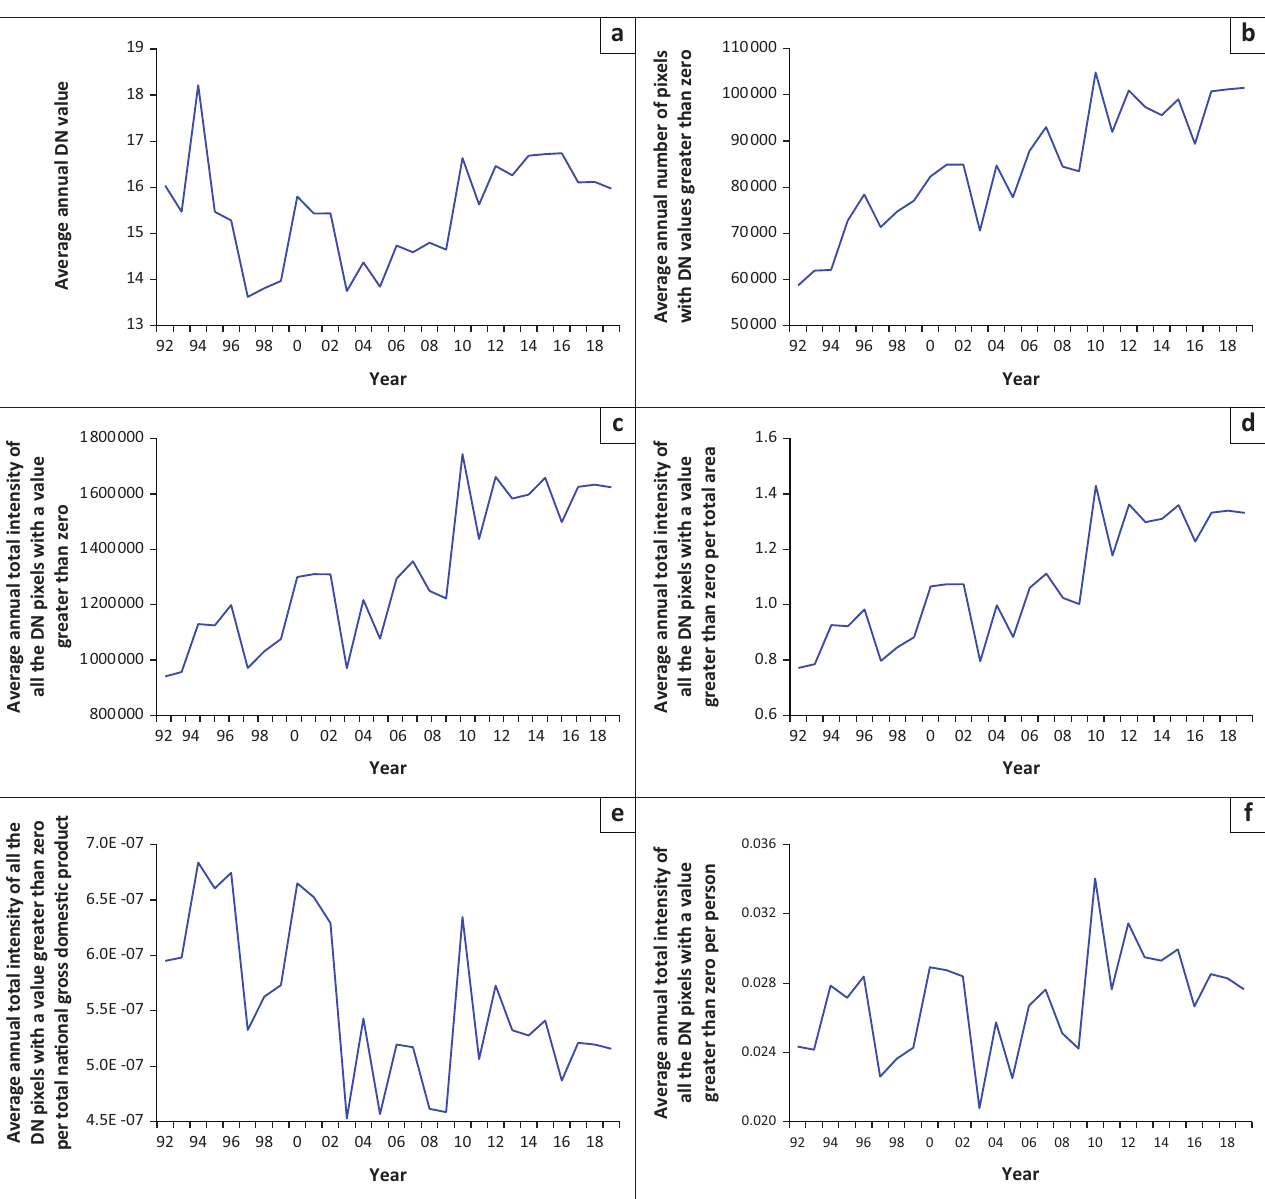
FIGURE 6: Night-time lights variables for South Africa, 1992–2019. (a), AVELIGHT; (b), COUNTLIGHT; (c), SUMLIGHT; (d), LIGHTKM; (e), LIGHTGDP and (f), LIGHTPOP.